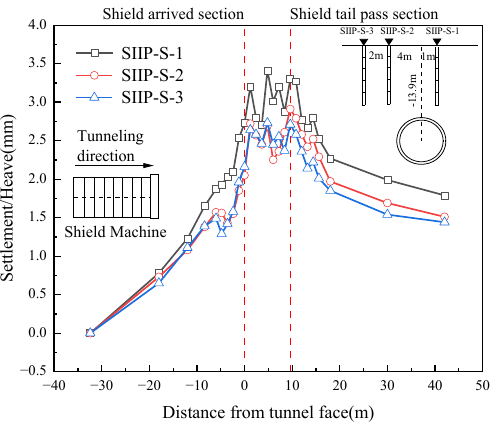
Figure 7. Development of surface settlement during tunneling in Section A.